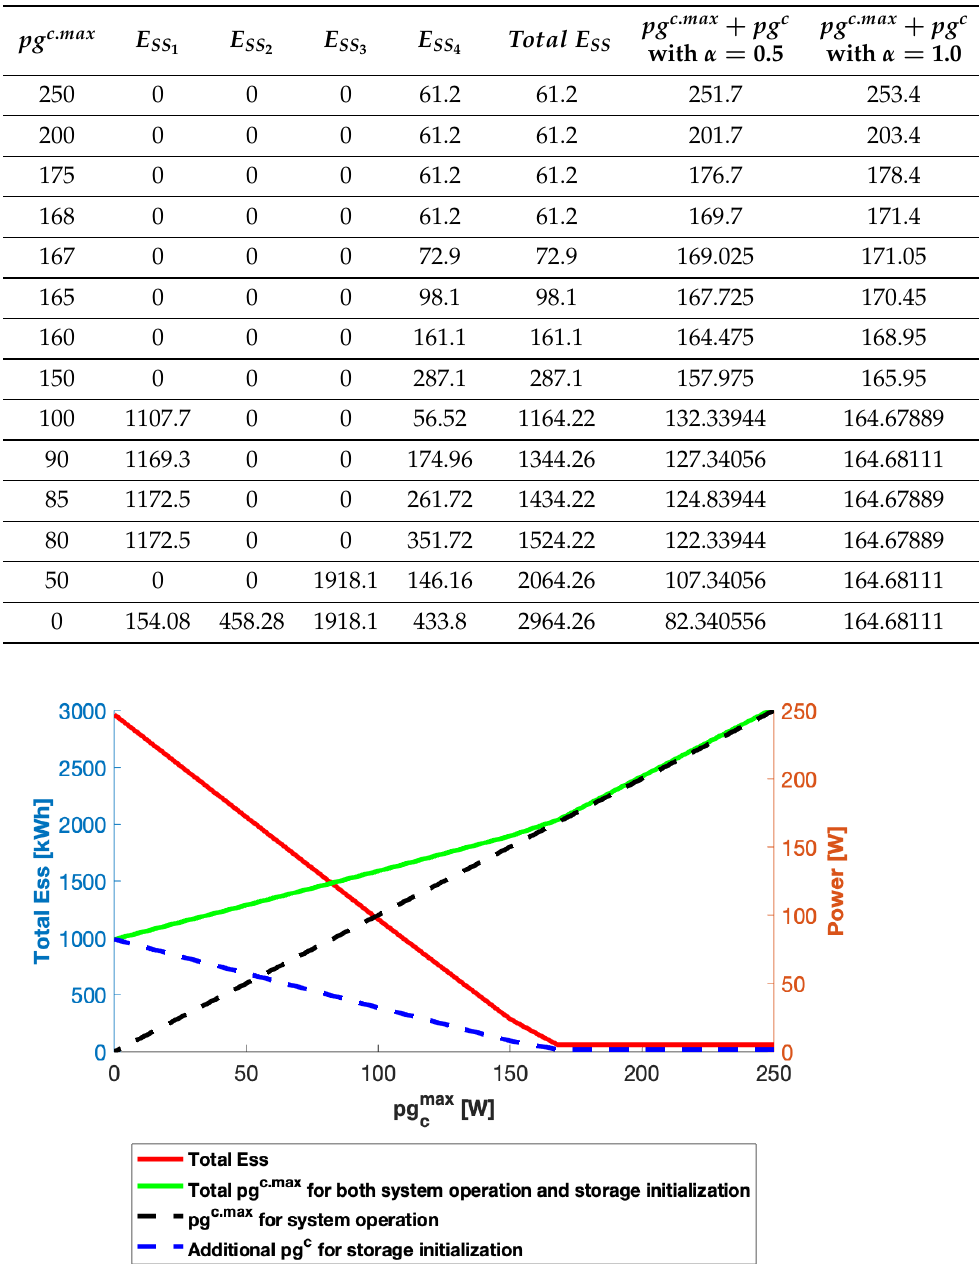
Table 1. List of optimal combinations of grid power and the size of storage devices.